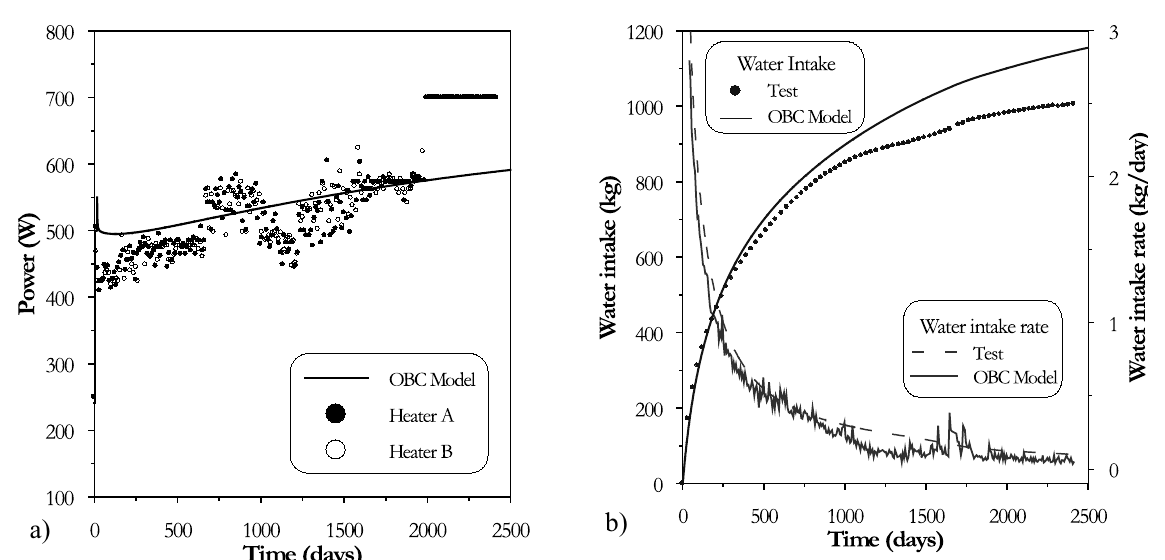
Fig. 8 – Measured and computed values in the mock-up test (OBC model). a) Evolution of heater. b) Evolution of water entry in the mock-up